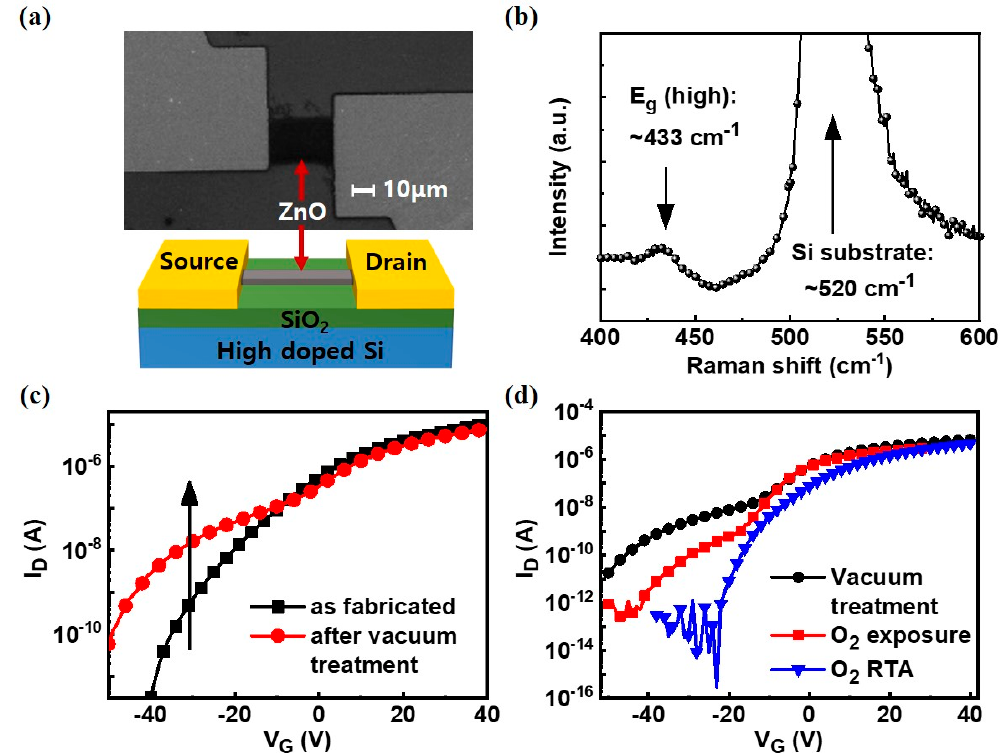
Figure 1. ( a ) SEM image of back gate ZnO thin-film transistors (TFT) and the schematic of the device structure. Channel width and length are 25 μ m and 30 μ m, respectively; ( b ) Raman spectrum of ZnO channel showing ZnO related peak at ~433 cm − 1 ; ( c ) representative transfer curves before (black) and after (red) the vacuum treatment at ~10 − 3 Torr for 24 h; ( d ) transfer curves after different treatments: Black circle line denotes the effect of low vacuum treatment; the red square, the sample exposed to oxygen atmosphere at 1 bar pressure and room temperature (25 °C) for 24 h; blue triangle, the effect of a rapid thermal annealing (RTA) system at 150 °C for 30 min, where the oxygen flow was maintained at 500 sccm.